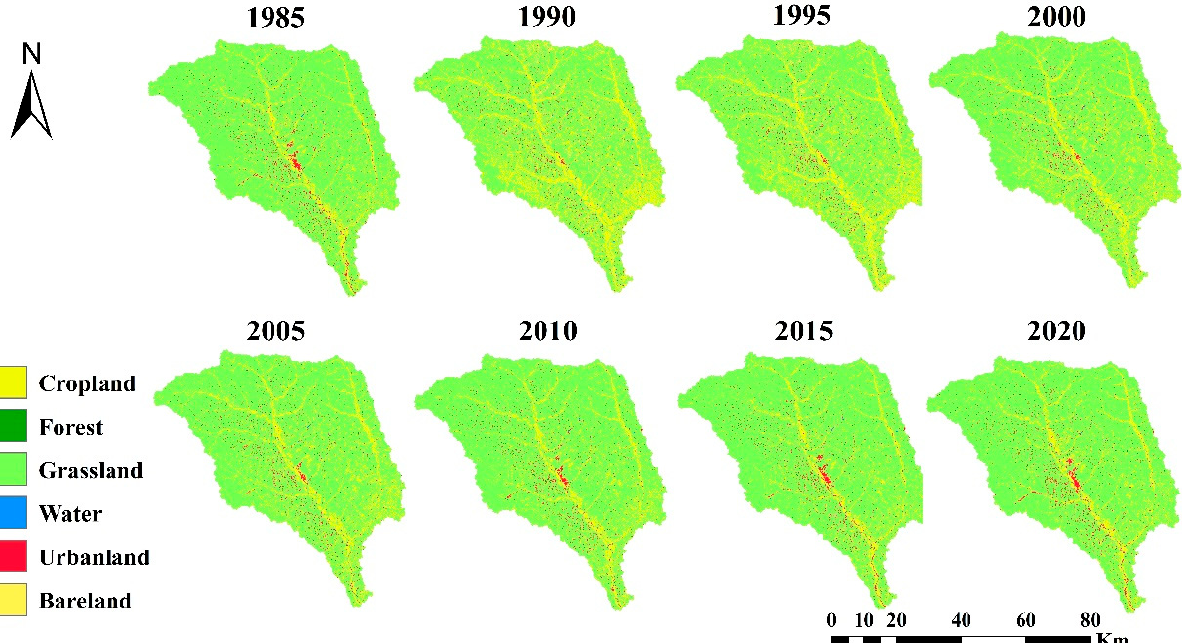
Figure 6. Land-use types of the Huangfuchuan Watershed from 1985 to 2020.